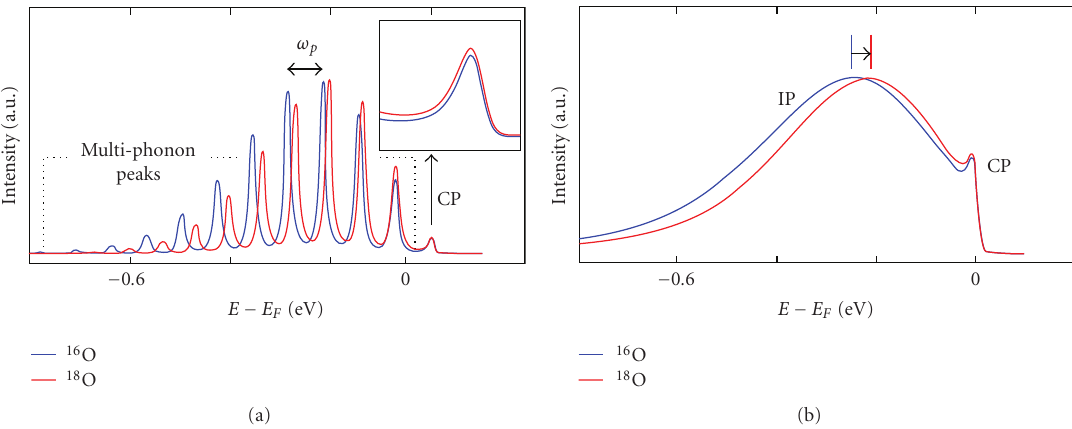
Figure 15: (a) Simulation of EDCs at k = k F for the o ff -nodal cut seen in Figure 13(b) modeled with a small polaron theory [47]. (b) The expected broadening of this lineshape showing the small IE at low energy (see panel (a) inset) with a more substantial IE shift at higher energy. The figures are from